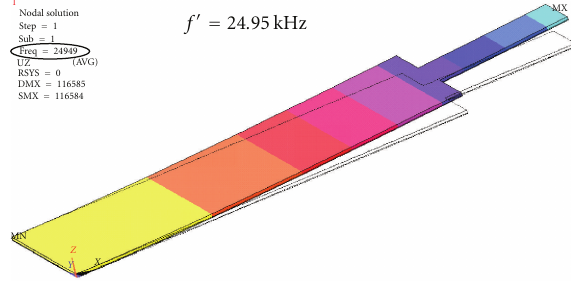
Figure 6: Deformed shape of the first vibration